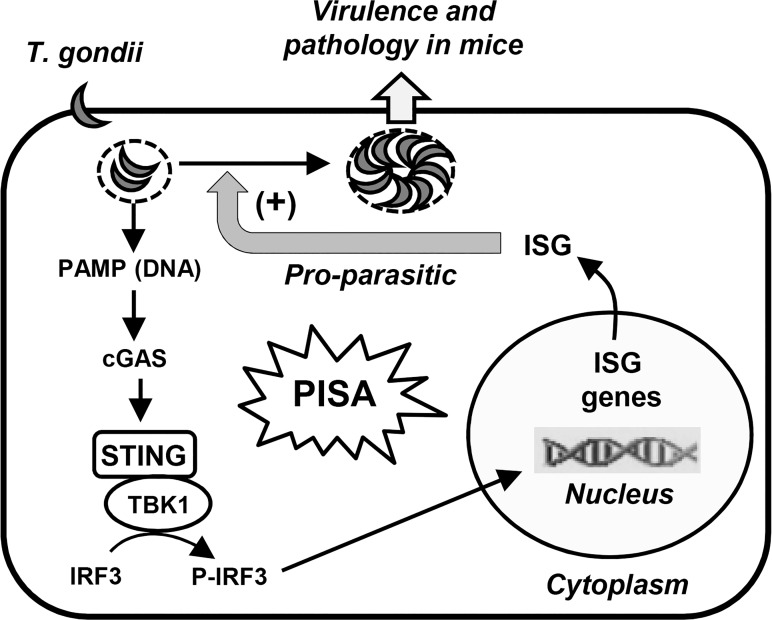
Our working model for PISA.In this model, a parasitic PAMP (possibly DNA) is sensed by the PRR, cGAS; the CDN product of cGAS then activates the STING-TBK1 kinase complex, which phosphorylates IRF3. The phospho-IRF3 translocates into the nucleus and leads to the induction of specific, parasite-friendly host gene(s), which facilitate T. gondii replication, thereby causing pathology and death.